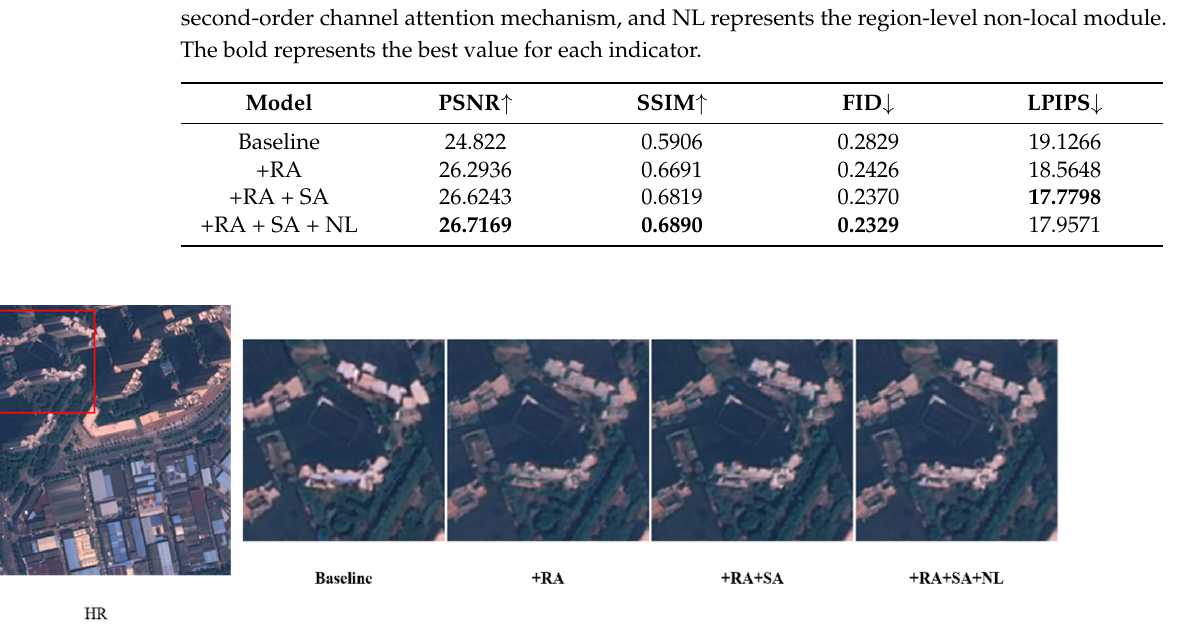
Table 5. The effect of gradual addition of different components on the performance of the model in relation to that of the baseline model. RA represents the region-aware strategy, SA represents the second-order channel attention mechanism, and NL represents the region-level non-local module. The bold represents the best value for each indicator